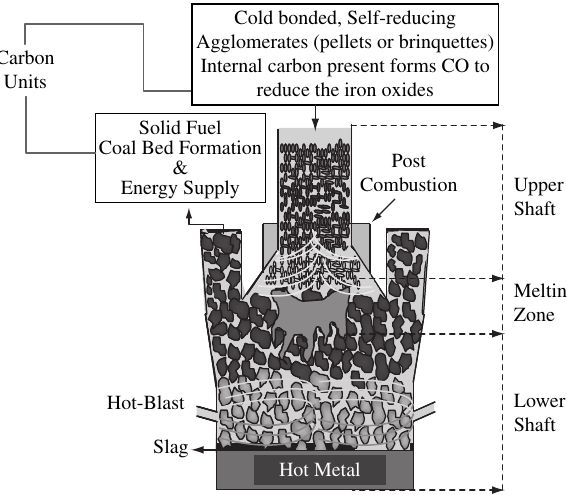
Figure 2. Cross sectional view of the Tecnored furnace.